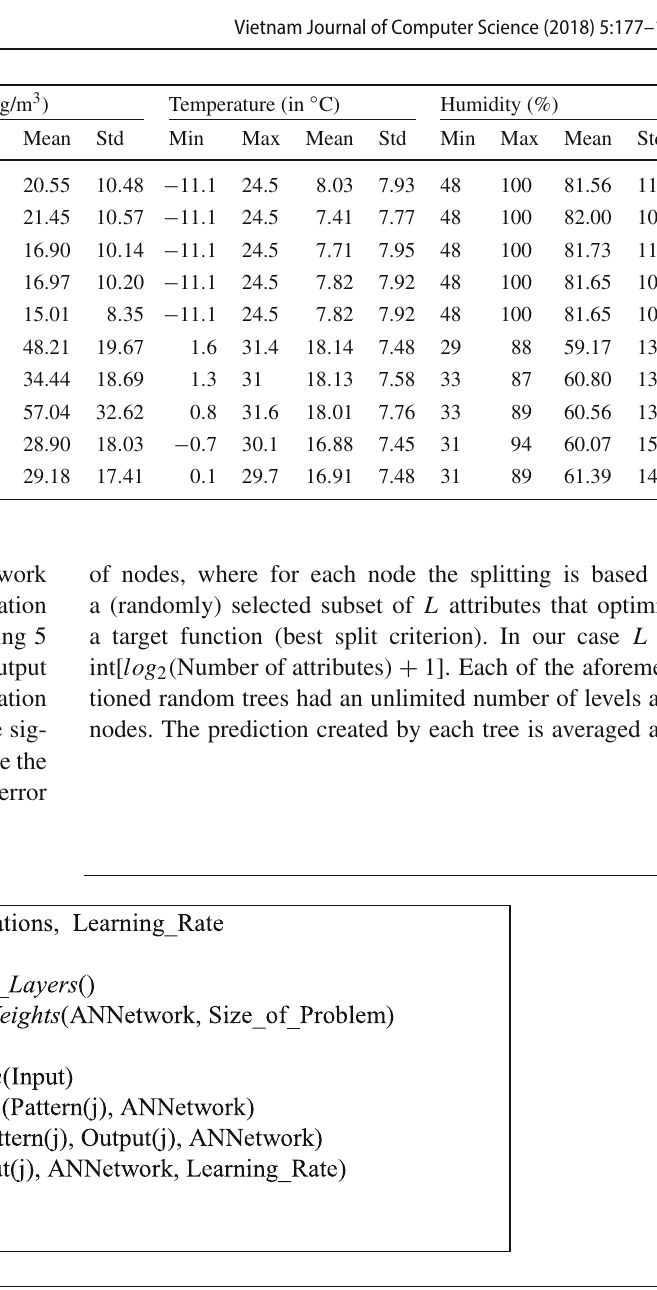
Table 2 Basic statistics for the AQ and meteorological parameters available for each station at GMA and TMA